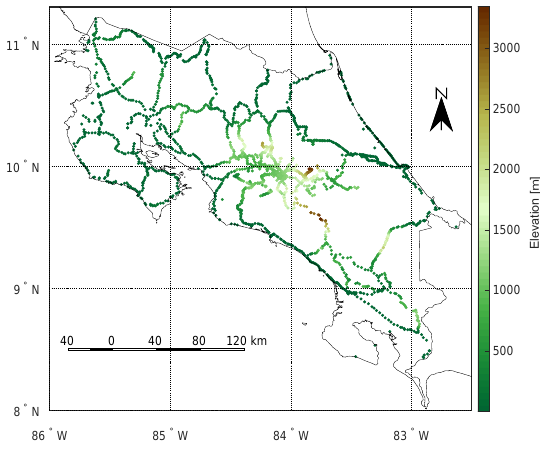
Figure 3. Locations and elevations of the 2233 points of the levelling dataset.